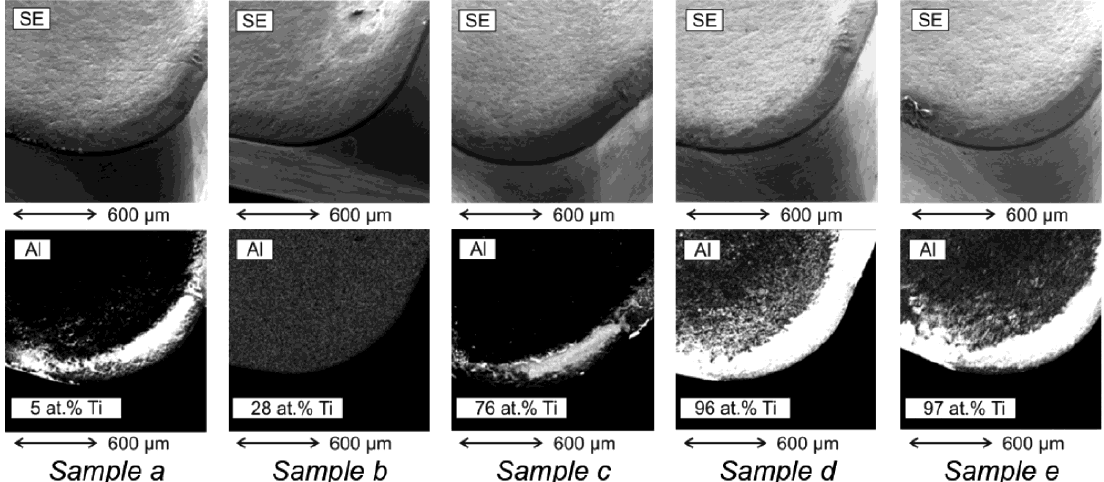
Figure 6. Aluminium element mapping images of flank face of mill inserts with Ti-MoS 2 coating after turning of 1800 mm. Element mapping obtained with EDX mode of SEM.